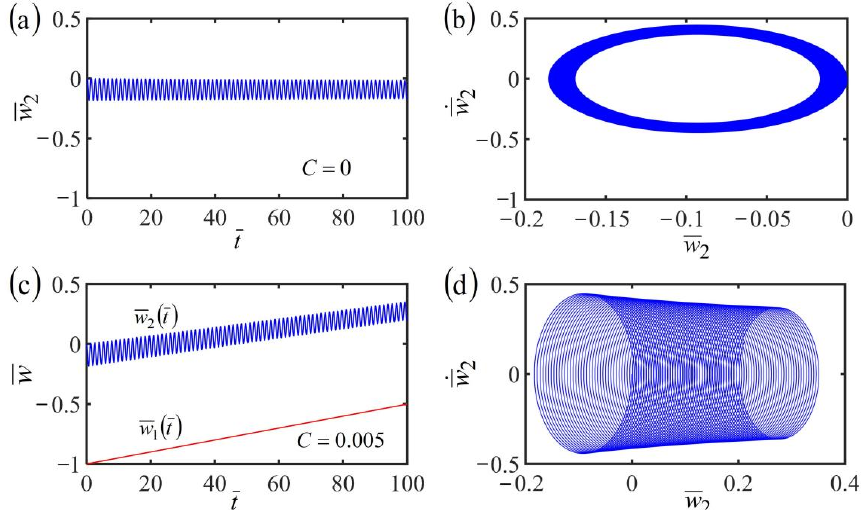
Figure 8. ( a ) Time history of the displacement and ( b ) phase trajectory of the self-oscillation in the case of the frame at rest in a linear temperature field. ( c ) Time history of the displacement and ( d ) phase trajectory of the self-oscillation in the case of the frame at uniform translation in a linear temperature field. The equilibrium position of mass and the length of fiber depend on the translation of